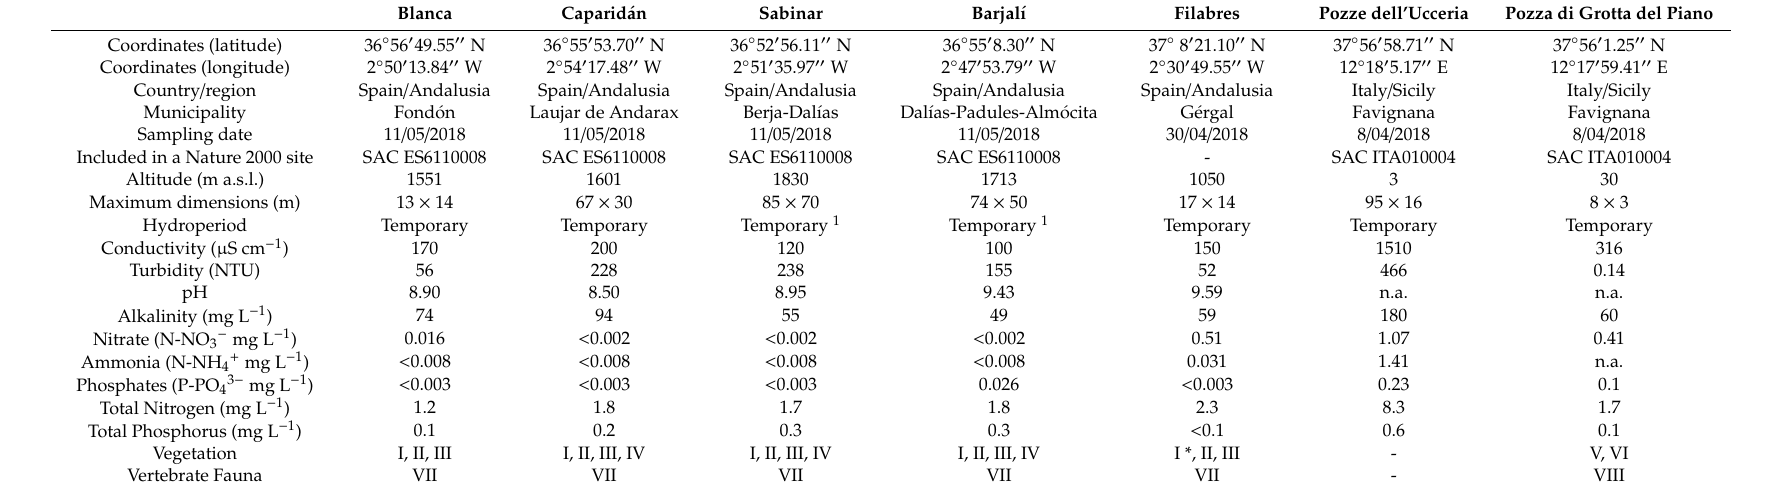
Table 1. List of the sampled localities and their chemical and physical features and biological communities at the sampling date. n.a.: not available. Aquatic vegetation: I: Tolypella prolifera (Ziz ex Braun) Leonhardi, 1863 (*) new locality for this species (the first record outside Sierra de G á dor); II: Ranunculus peltatus subsp. saniculifolius (Viv.) C.D.K. Cook, 1984; III: Eleocharis palustris (L.) Roem. & Schult., 1817; IV: Coronopus navasii Pau, 1922; V: Callitriche sp.; VI: Elatine macropoda Guss., 1827. Vertebrate fauna: VII: Epidalea calamita (Laurenti, 1768); VIII: Bufotes boulengeri siculus (Stöck, Sicilia, Belfiore, Buckley, Lo Brutto, Lo Valvo & Arculeo, 2008).